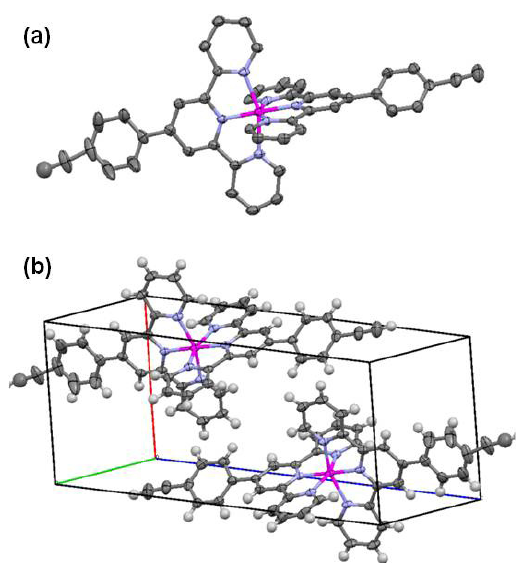
Figure 2. a) Representation of the X-ray single crystal structure of Ru2 (thermal ellipsoids at 50% probability level, hydrogen atoms omitted for clarity). (b) Elemental cell and packing of Ru2 (counterions and solvent molecules are not